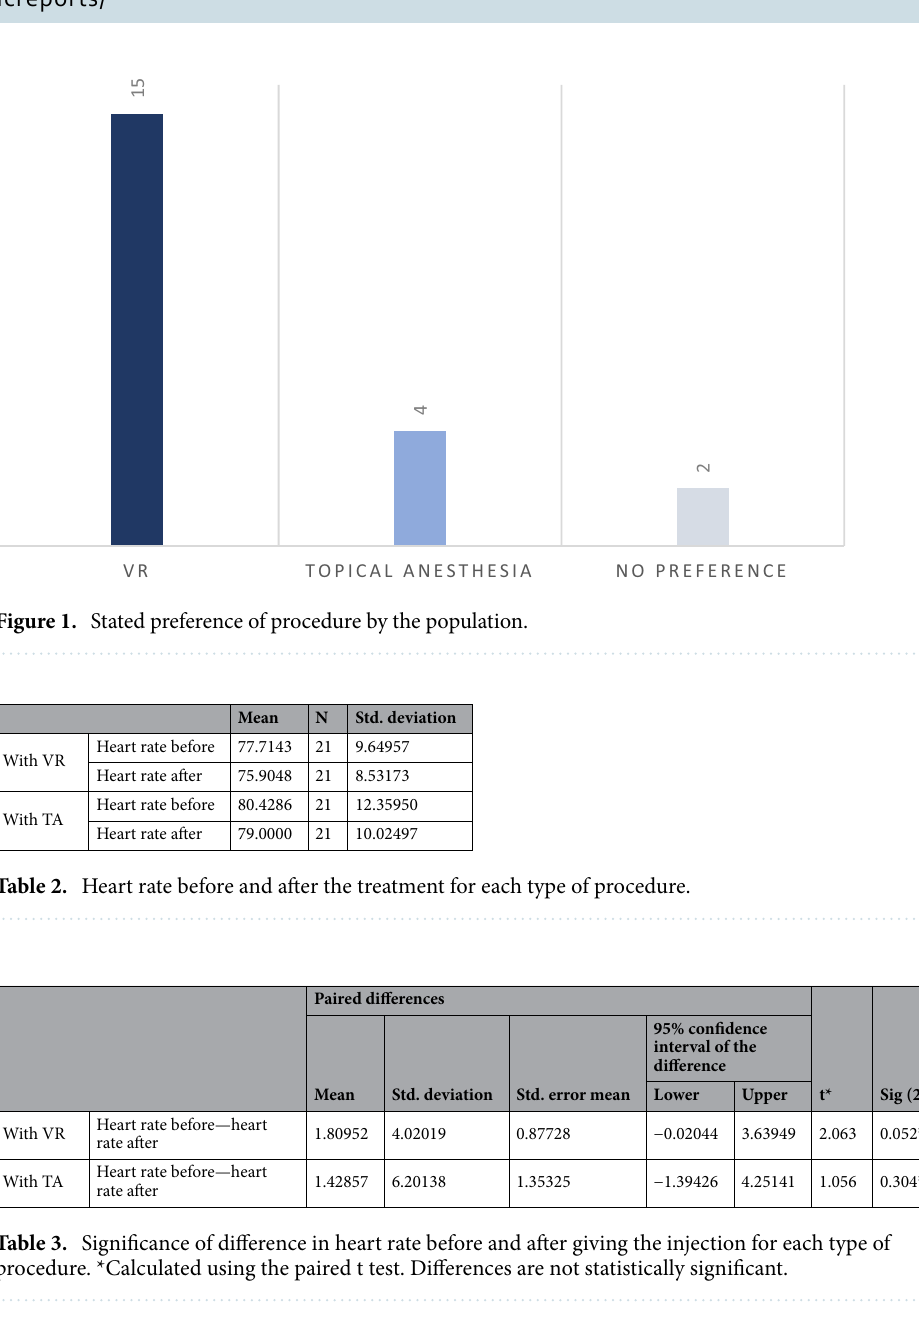
Table 3. Significance of difference in heart rate before and after giving the injection for each type of procedure. *Calculated using the paired t test. Differences are not statistically significant.